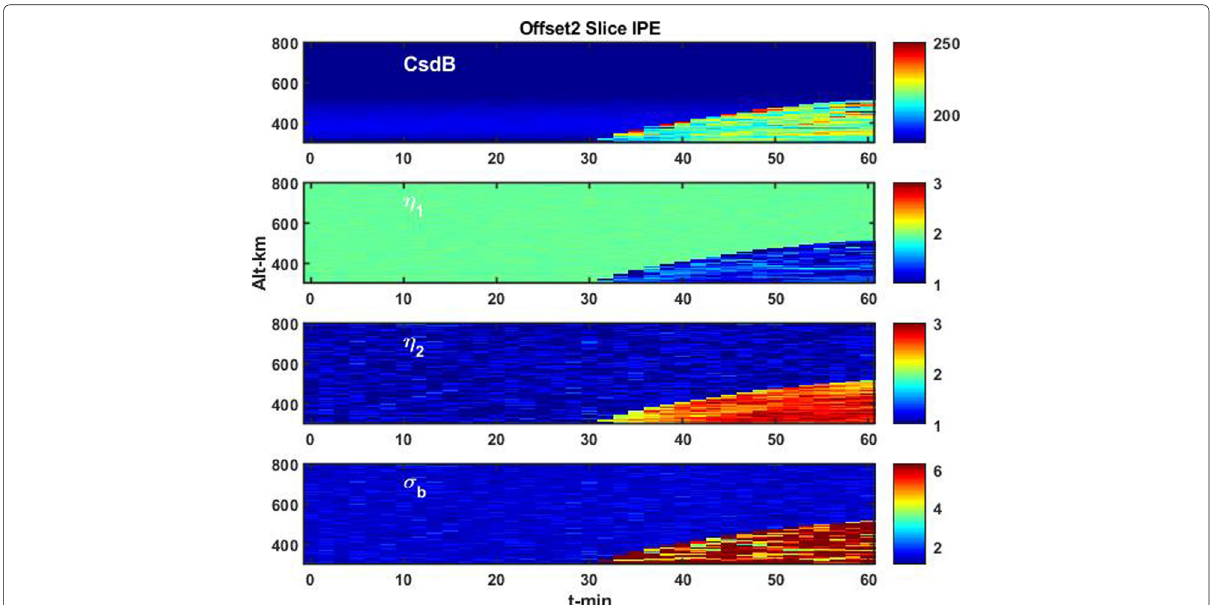
Fig. 10 MLE-IPE SDF parameter estimates from offset2 slice plane realizations at 100 s, where σ b = 2 π/ q